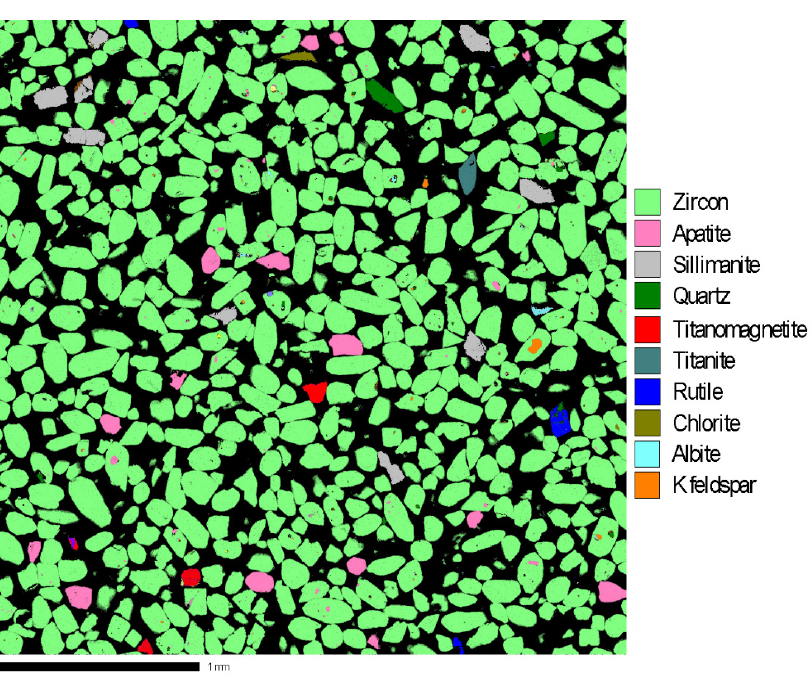
Figure 8. EPMA map results for the zircon concentrate showing the phase patched map with the distribution of all phases present in the sample. Operating conditions for the microprobe during mapping were an accelerating voltage of 15 keV, a beam current of 80 nA, a step size of 3 µ m (in x and y) and a counting time of 30 ms per step.